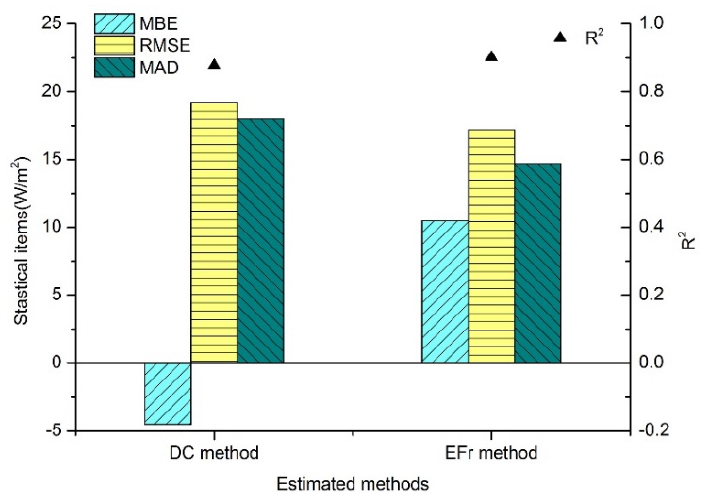
Figure 8. Statistical items for daily ET estimations calculated directly by the DC method and temporal upscaled by the EFr method based on MODIS data against with corrected ET measurements by the BR scheme.